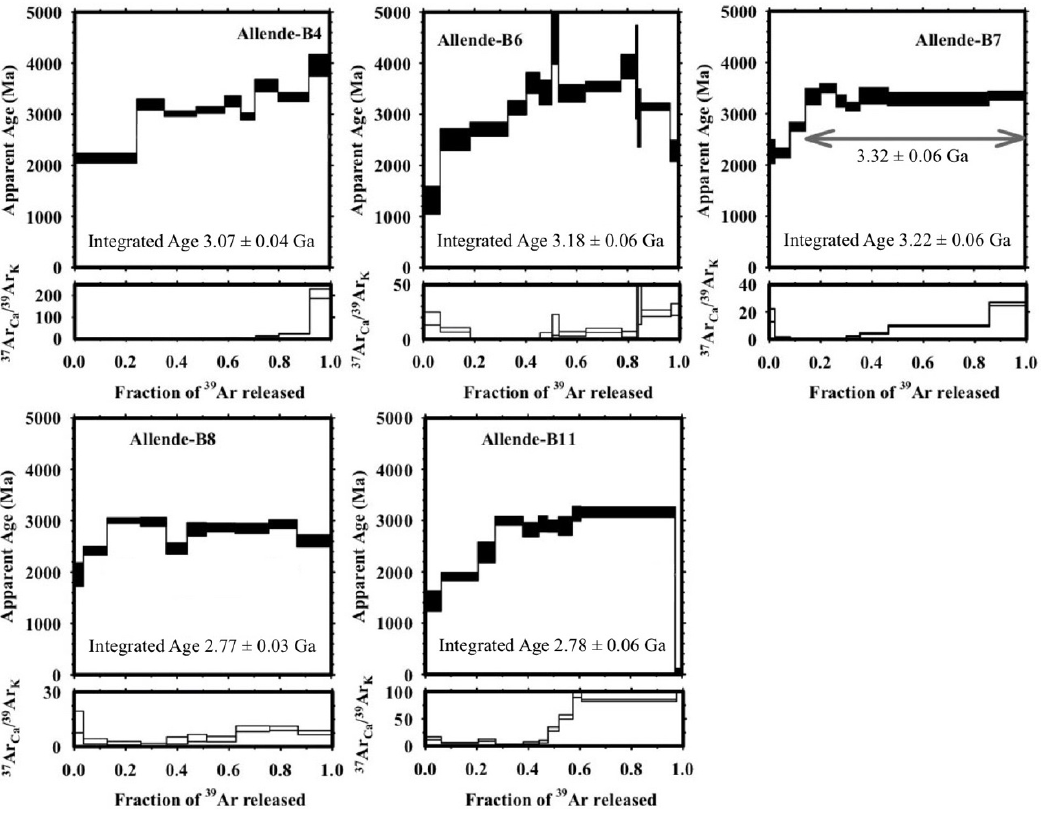
Figure 10. Age spectra and 37 Ar Ca / 39 Ar K ratios of bulk chondrules by laser step-heating analyses.